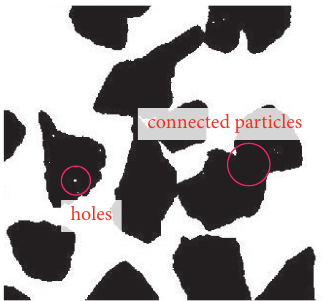
Figure 8: Problems existing in neural network output